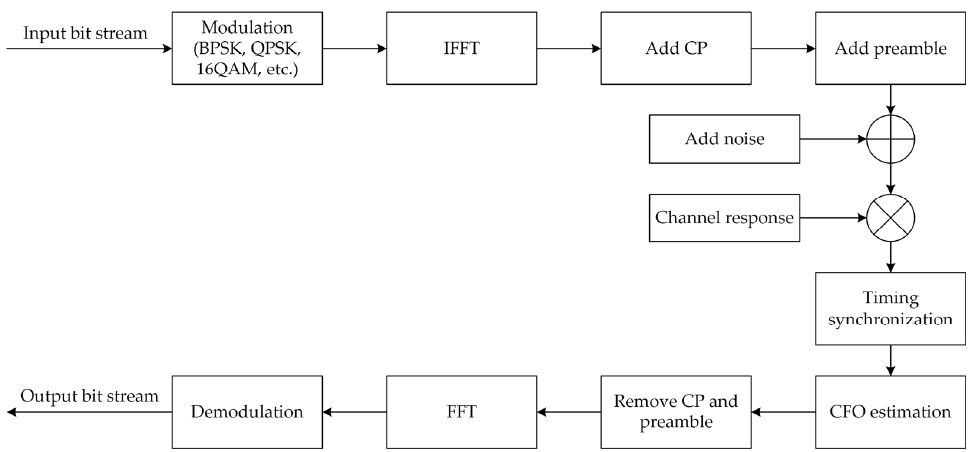
Figure 1. General model of an OFDM system.